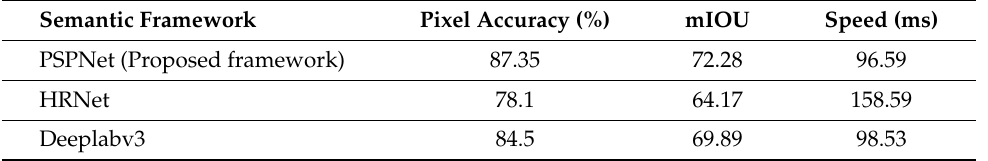
Table 5. Comparison with other semantic segmentation framework.